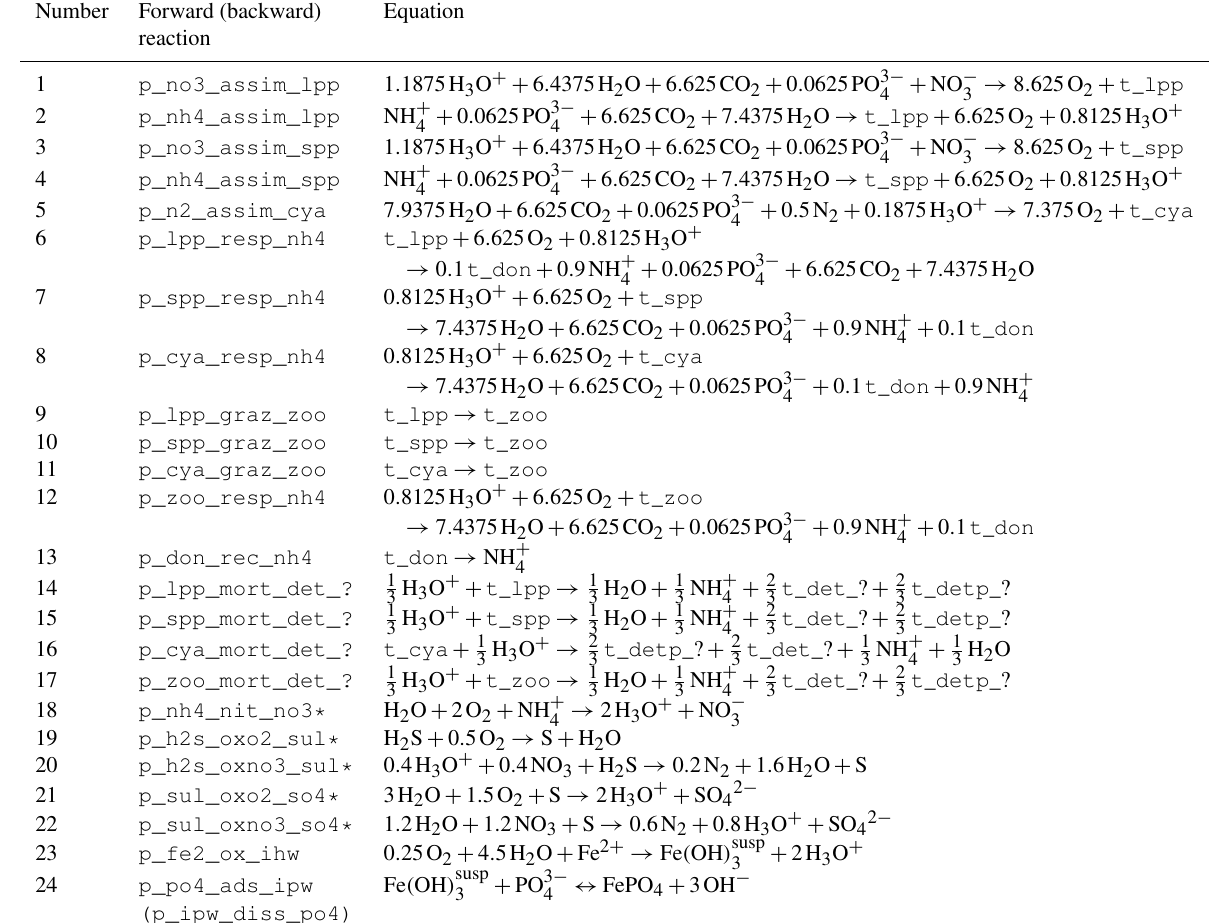
Table 2. Reaction network table for the processes in the water column. See Table A1 for the composition of state variables. Processes marked with * also take place in the pore